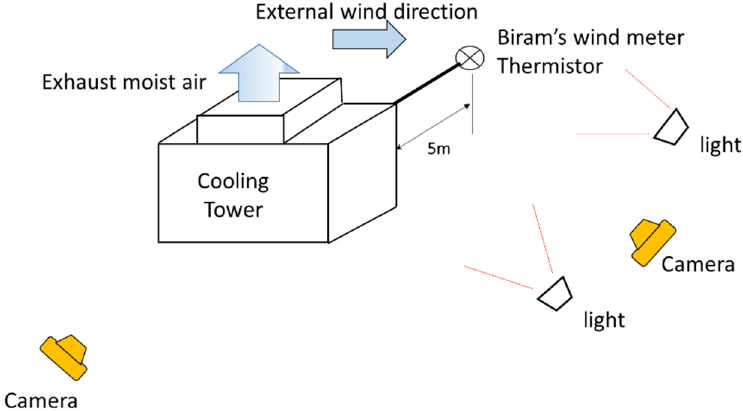
Figure 6. Schematic picture of observation and measuring condition of visible plume and external wind velocity and temperature.